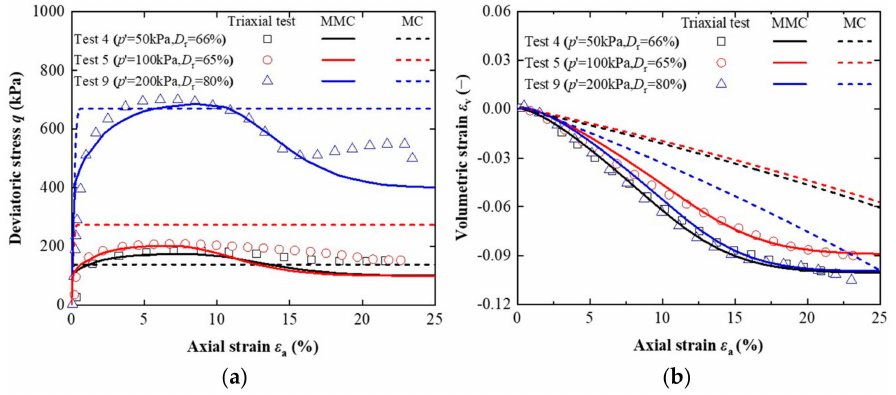
Figure 5. Comparison of FE simulation and triaxial compression soil element tests: ( a ) stress–strain behavior; ( b ) volume change behavior.